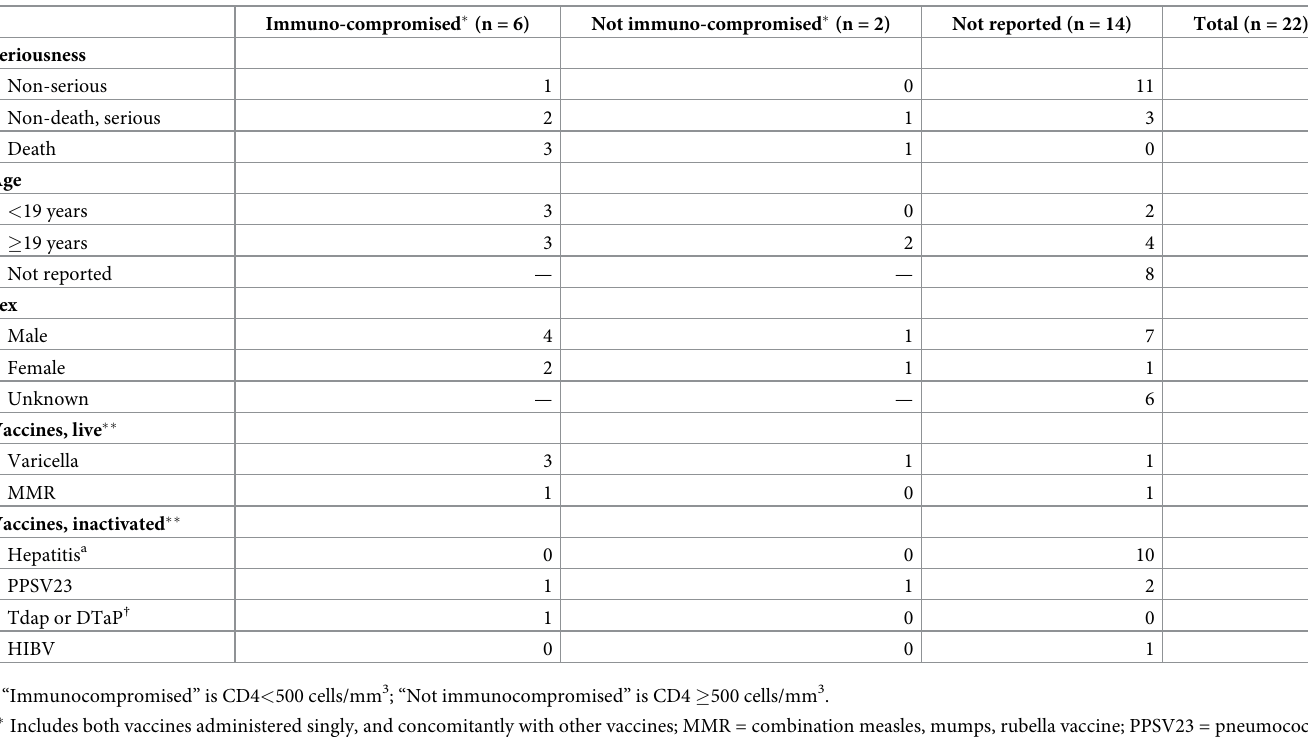
Table 3. Reports to VAERS of drug ineffectiveness/vaccine inefficacy by immune status among HIV-positive persons, 1990–2016. Immuno-compromised (cid:3) (n =